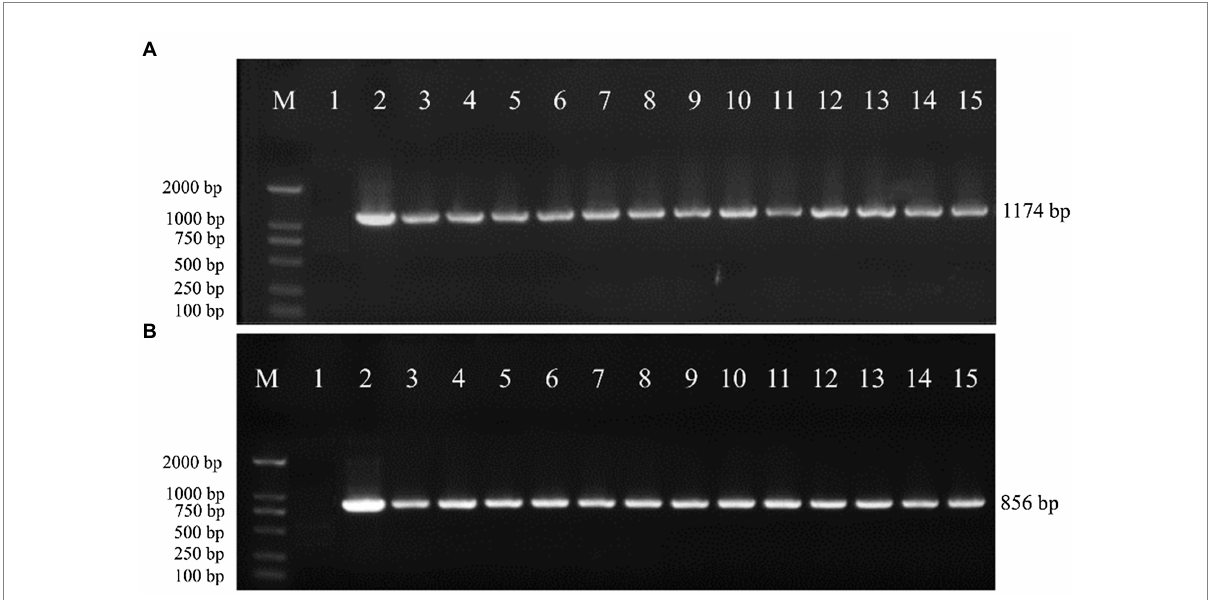
FIGURE 3 Genomic DNA extraction and PCR identification of M. importuna transformants. (A) M04M24 strain transformant transformed with pEH2B vector. Primers eyz-F/R were used to amplify H2B-eGFP insertion fragment. Lane1, untransformed M04M24 strain; Lane2, pEH2B plasmid; Lane3-15, randomly selected transformants of pEH2B. (B) M04M26 strain transformant transformed with pMH2B vector. Primers myz-F/R were used to amplify H2B-mCherry insertion fragment. Lane1, untransformed M04M26 strain; Lane2. pMH2B plasmid; Lane3-15, randomly selected transformants of pMH2B. M, BM2000 marker (Biomed, Beijing, China). The expected size of PCR products is indicated on the right.